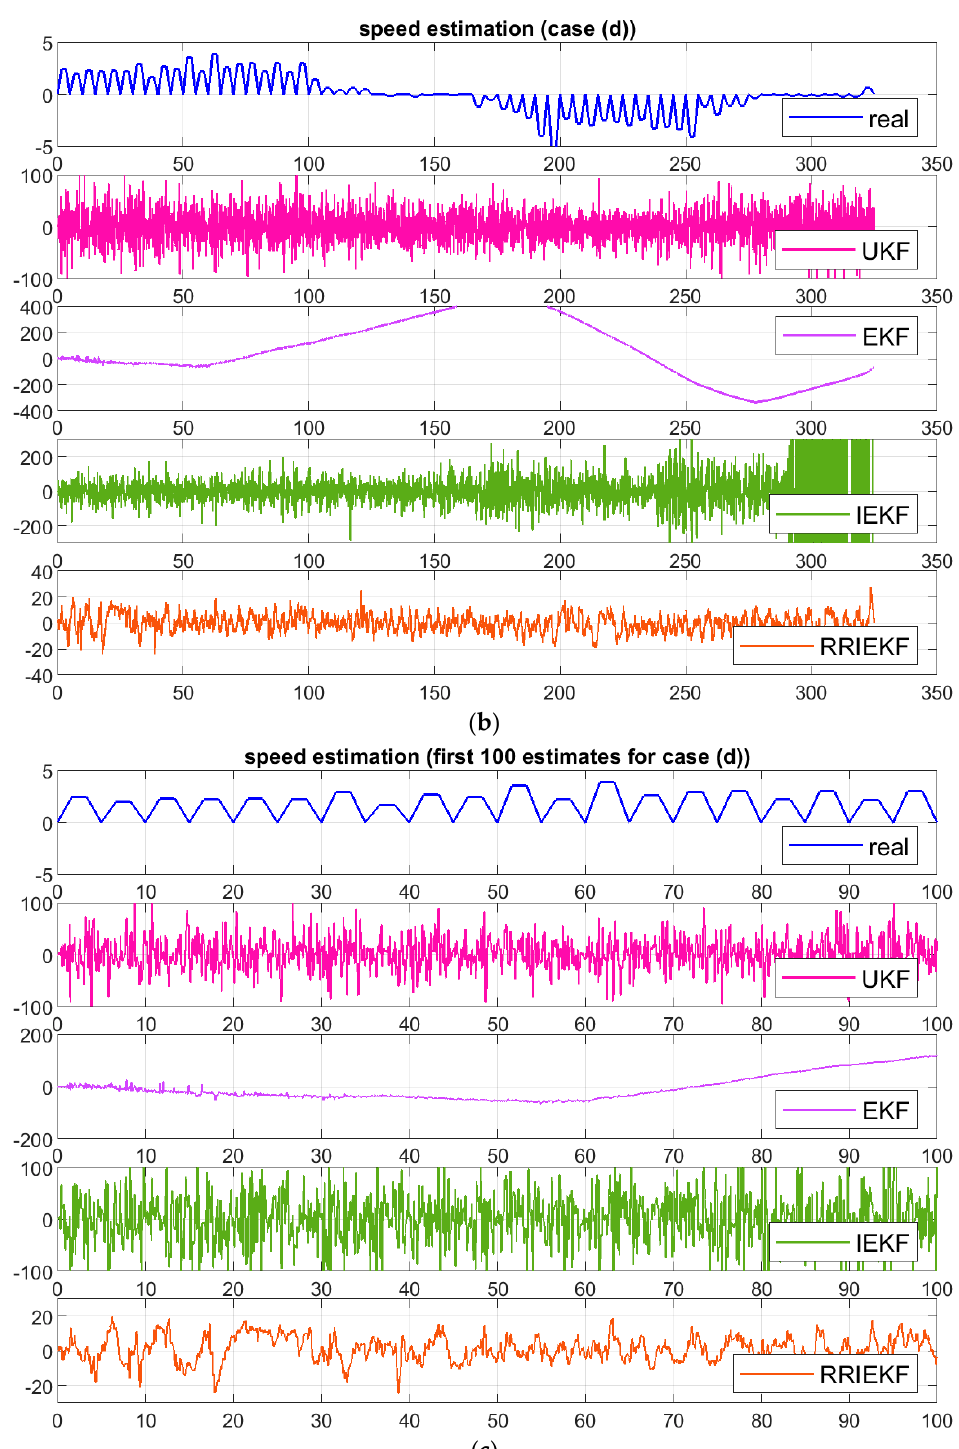
Figure 8. ( a ) Estimated speed along x axis for case (a), ( b ) Estimated speed along x axis for case (d). ( c ) First 100 estimates for case (d).